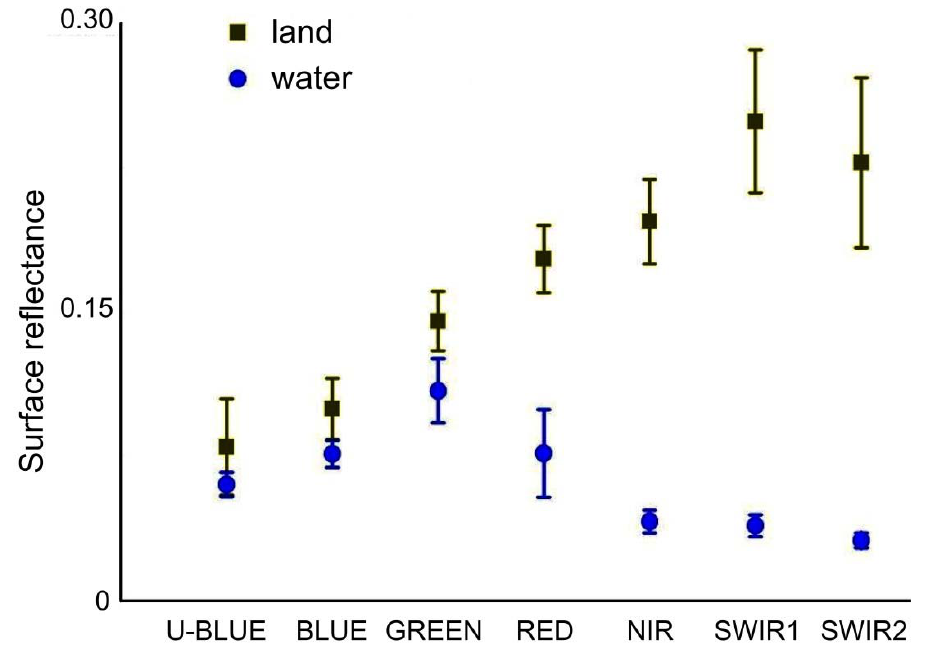
Figure 3. Distribution of the surface reflectance ranges of pure water and land samples on Landsat-8 OLI bands.